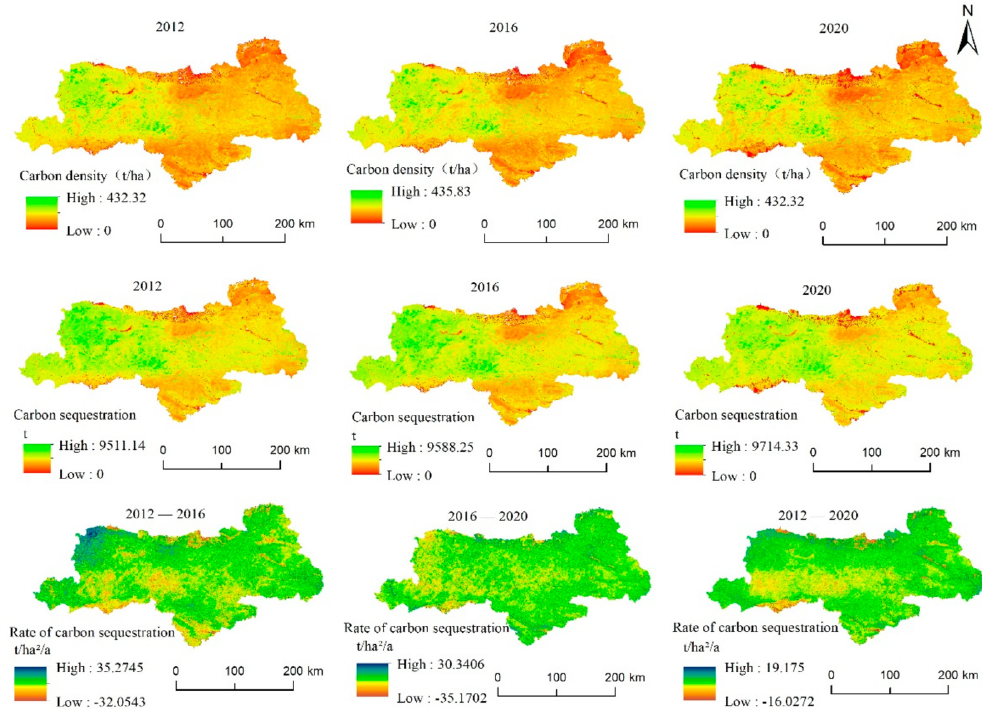
Figure 2. Spatial distribution of carbon density, carbon sequestration, and carbon sequestration rate in Qinling